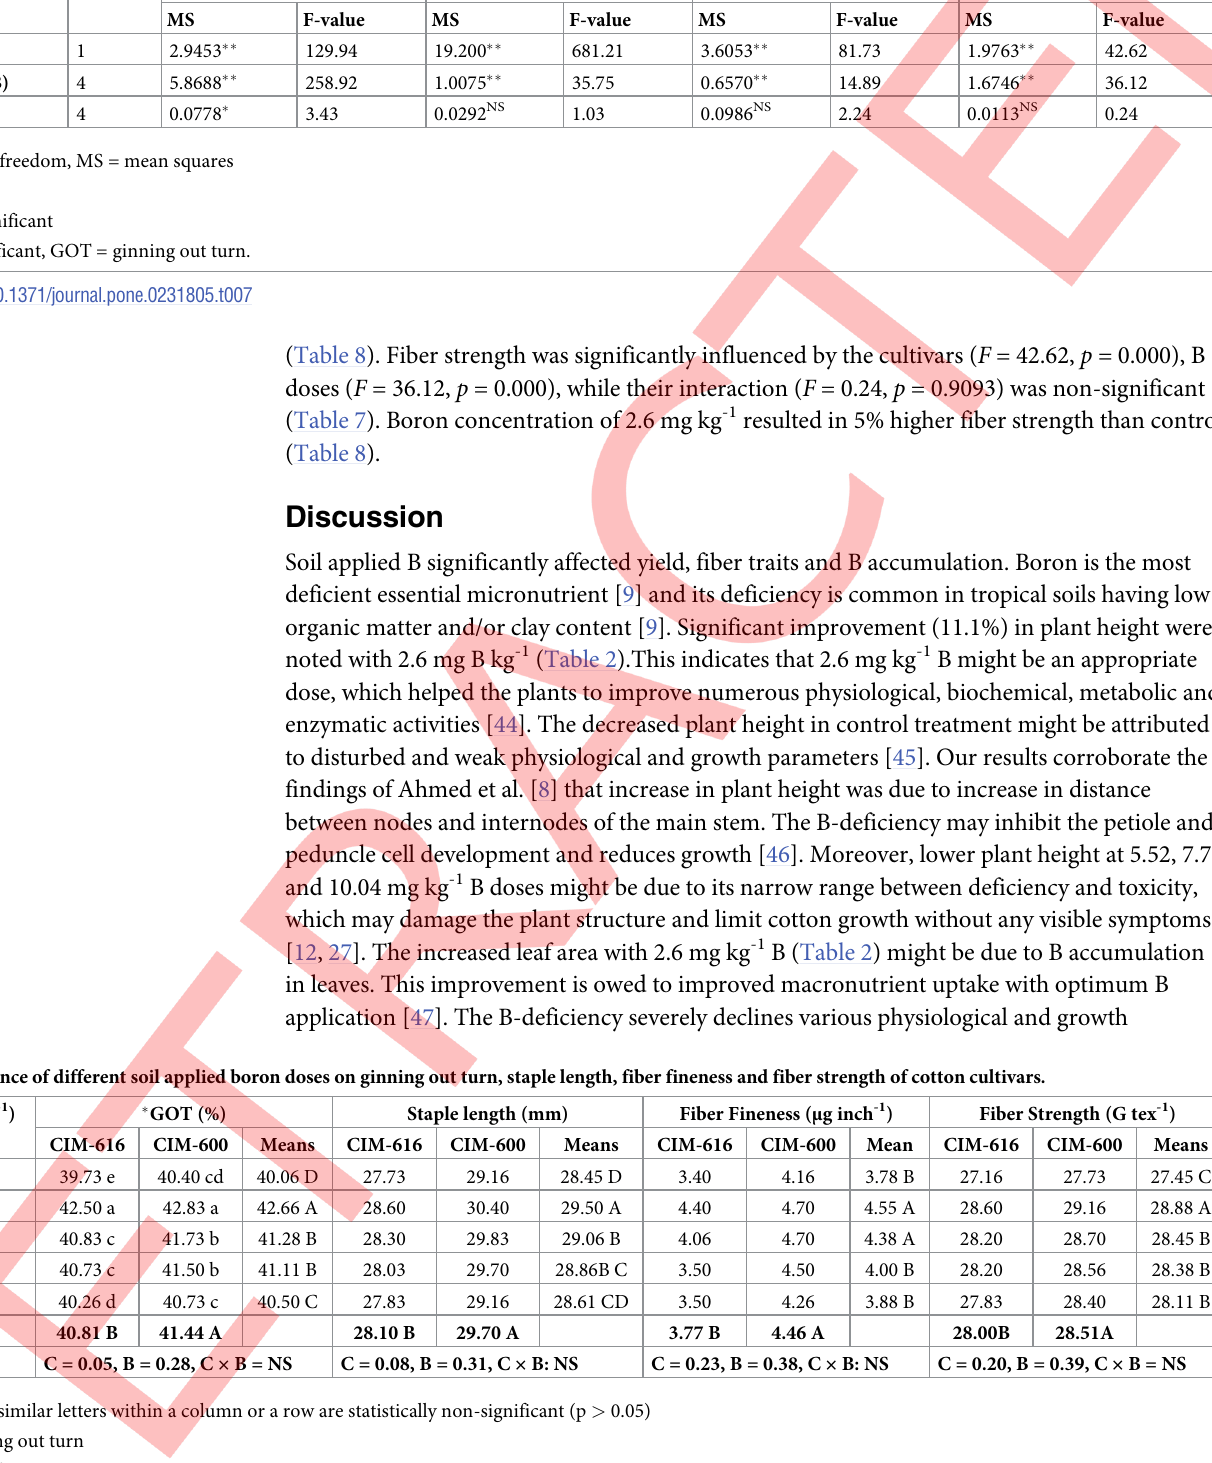
Table 7. Analysis of variance of different soil applied boron doses on ginning out turn, staple length, fiber fineness and fiber strength of cotton cultivars. SOV DF